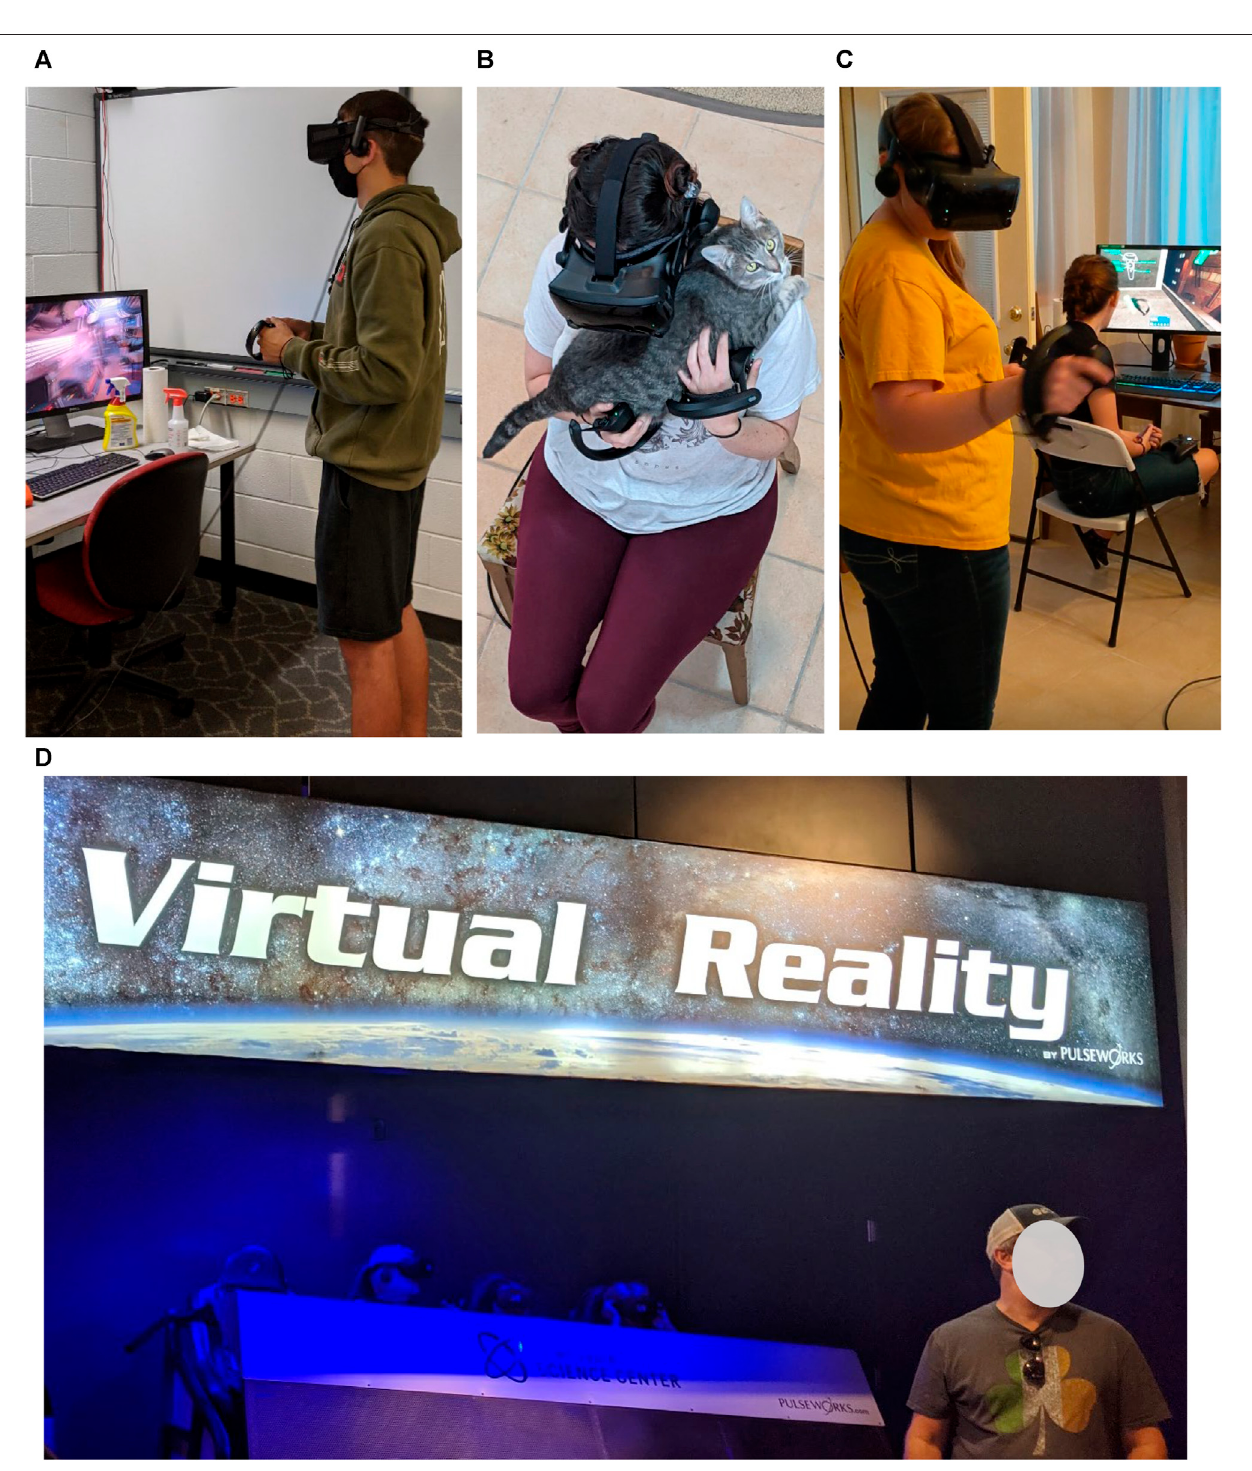
FIGURE 2 | Visual examples of the identi fi ed settings: (A) Online, indicating the social interaction surrounding use of a single VR HMD happens over a network connection and may be displayed on the monitor; (B) Casual, indicating the “ everyday use ” of VR; (C) Party, indicating VR use in a social setting as part of an event dedicatedtousingVR,especiallywithfriends orcolleagues; (D) Demonstration,indicatingtheintroduction ofVRtonewuser(s)inpublicorprivate settings.Photosused with permission from Author 1 per CC-BY-NC-ND.